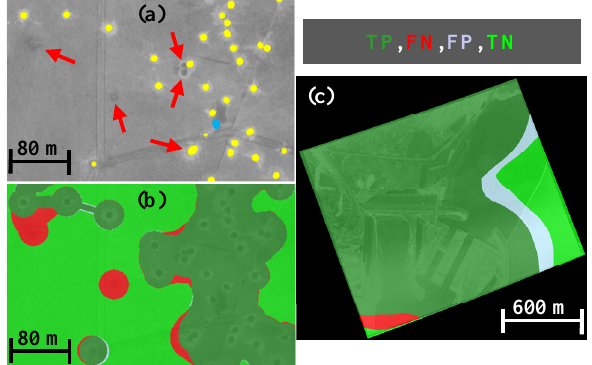
Figure 4: Subset of the aerial wartime image VII with the final object configuration for the marked point process procedure (ellipses) with correct detections in yellow and false detections in cyan (a), the derived impact map for Scenario 1, showing the superposition of the impact maps for the reference and the automatic results with TP-areas in dark green, FN-areas in red, FP-areas in pale blue and TN-areas in lime green (b) and the impact map superimposed on data set V for Scenario 2